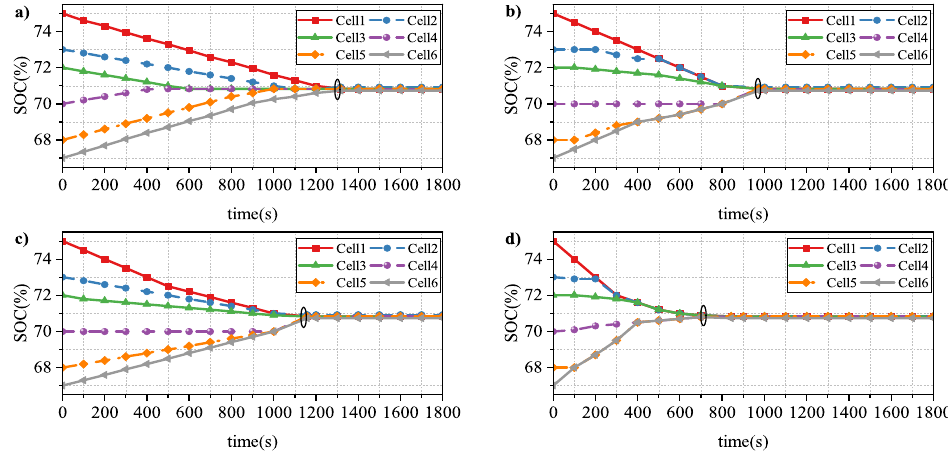
Figure 10. Equilibrium process of the four circuits in the static state: ( a ) Pattern 1; ( b ) Pattern 2; ( c ) Pattern 3; and ( d ) Pattern 4.